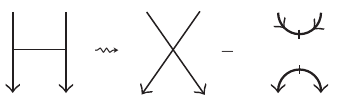
Figure A.5 . The map β